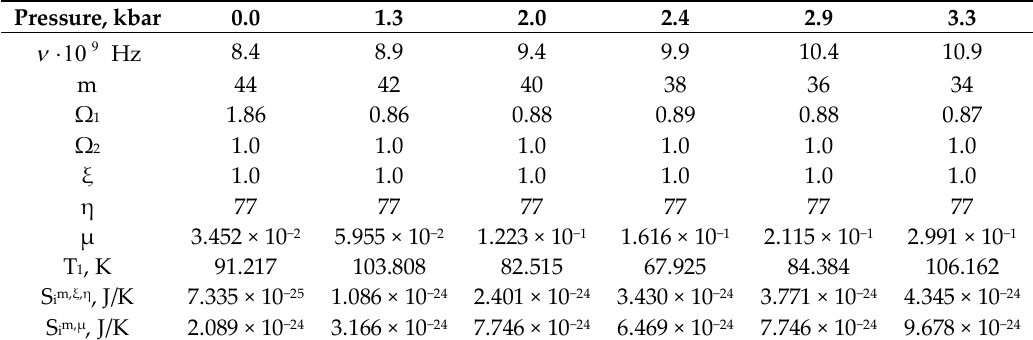
Table 5. Information entropy of the double proton transfer in the polycrystalline benzoic acid sample under various hydrostatic